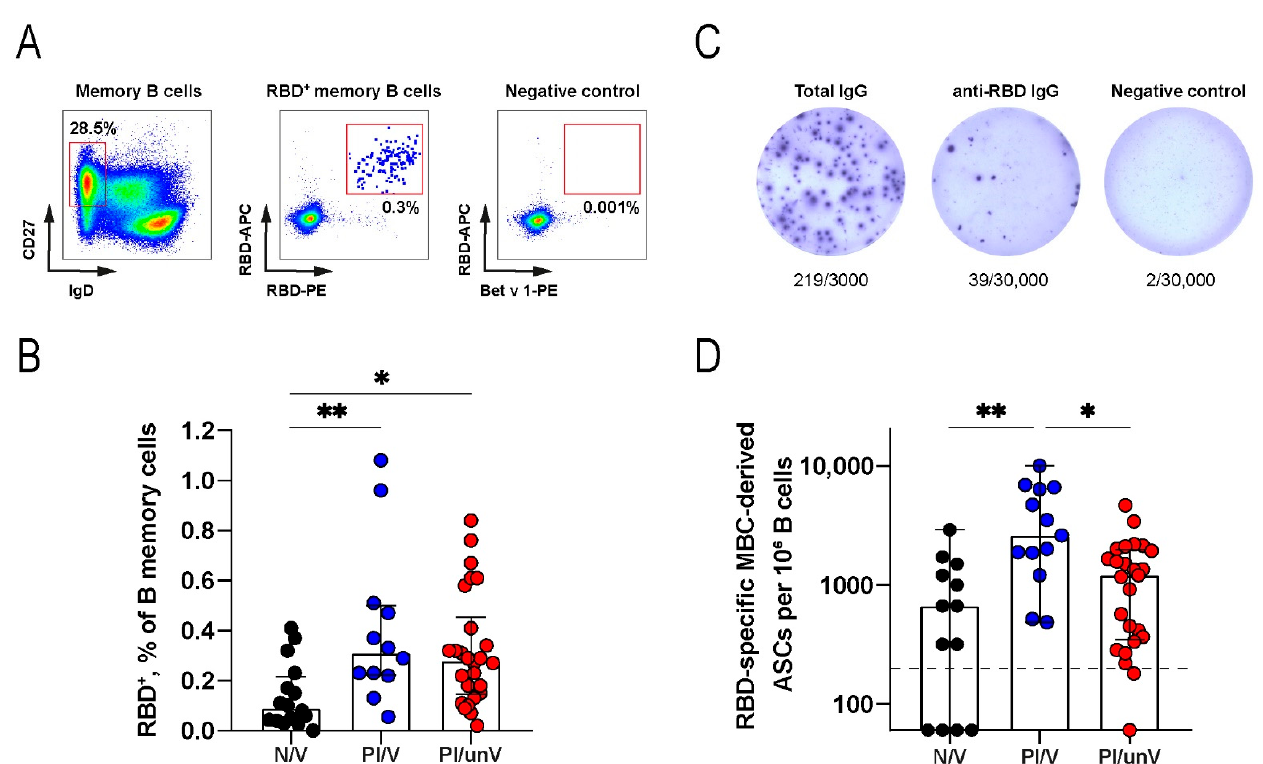
Figure 2. Analysis of circulating memory B-cells in COVID-19 convalescent patients and Gam- COVID-Vac recipients. ( A ) Representative flow cytometry dot plots showing dual PE–RBD- and APC–RBD-binding MBCs. Numbers inside the plots indicate the percentage of events specific to the respective gates. ( B ) RBD + MBCs as a percentage of all memory B-cells (CD19 + CD27 + IgD − ). ( C ) Representative ELISpot showing SARS-CoV-2-specific MBC-derived ASCs. Purified B-cells were stimulated with IL-21/CD40L for 7 days and then incubated in ELISpot plates for 16 h to detect ASCs secreting total (left), RBD-specific (middle) or IgG against irrelevant Bet v 1 protein (right). The numbers indicated below the wells represent positive dots and the total number of cells in the well.